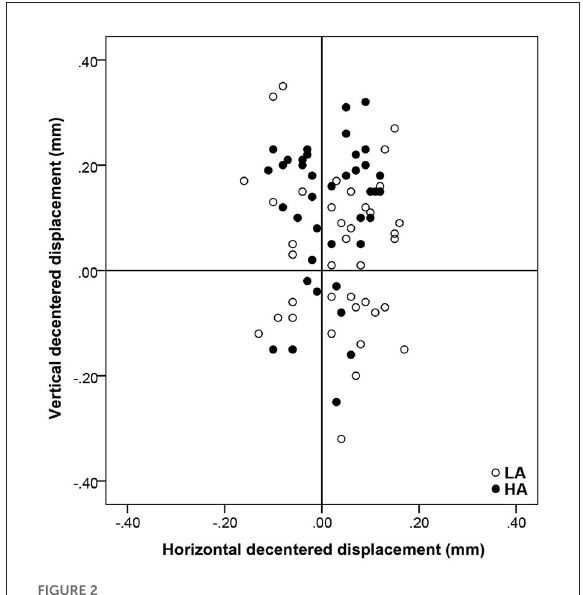
FIGURE2 The location of optical zone center and the distribution of decentration distance relative to the corneal vertex. Positive vertical coordinates stand for superior displacements and negative for inferior ones. Positive horizontal coordinates stand for nasal displacements and negative for temporal ones.